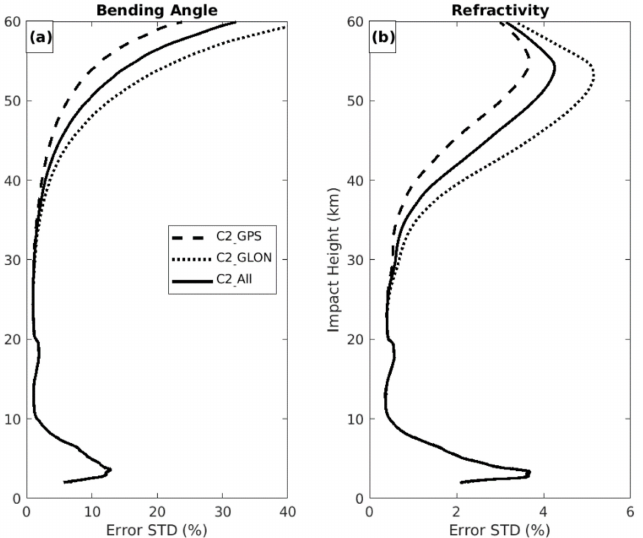
Figure 5. C2 uncertainties (3CH error STD) for August 2021 for all profiles (GPS and GLONASS, solid line), GPS only (dashed line), and GLONASS only (dotted line). ( a ) bending angle, ( b )